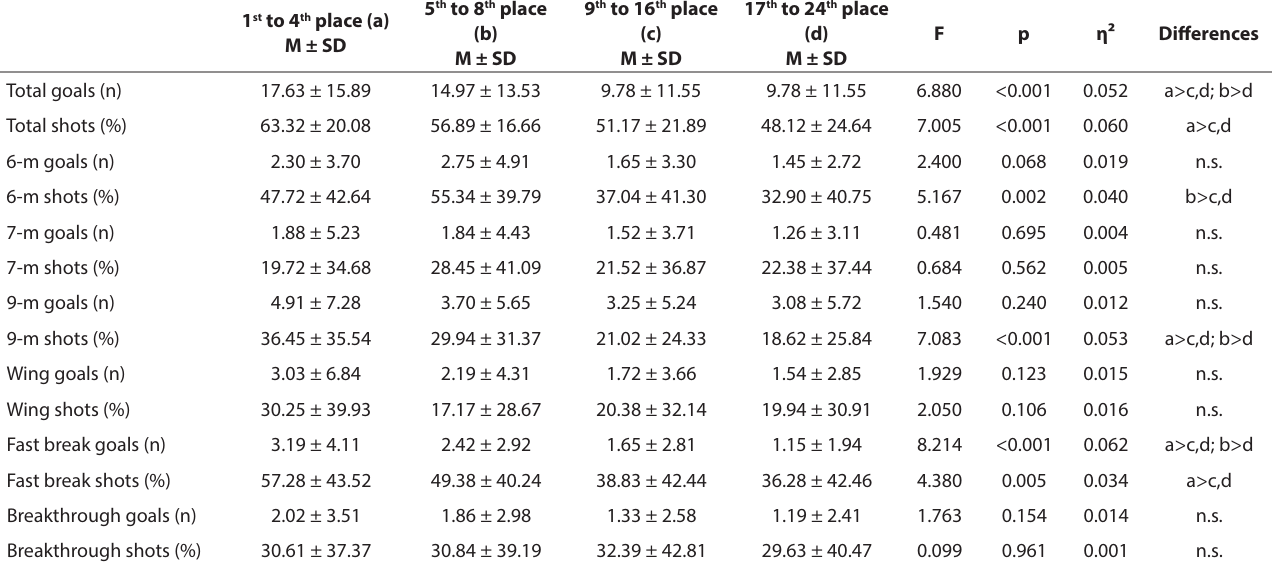
TABLE 4. Mean and standard deviation of each variable. A one-way analysis of variance (ANOVA) with Tukey posthoc test was used to compare means between team classifications (Eta squared is also given) 1 st to 4 th place (a)